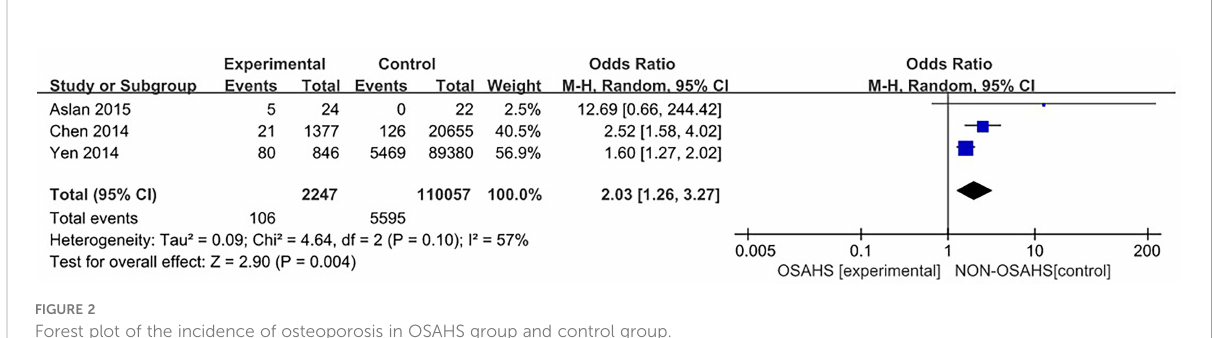
prevalence of osteoporosis and is a risk factor for the disease.